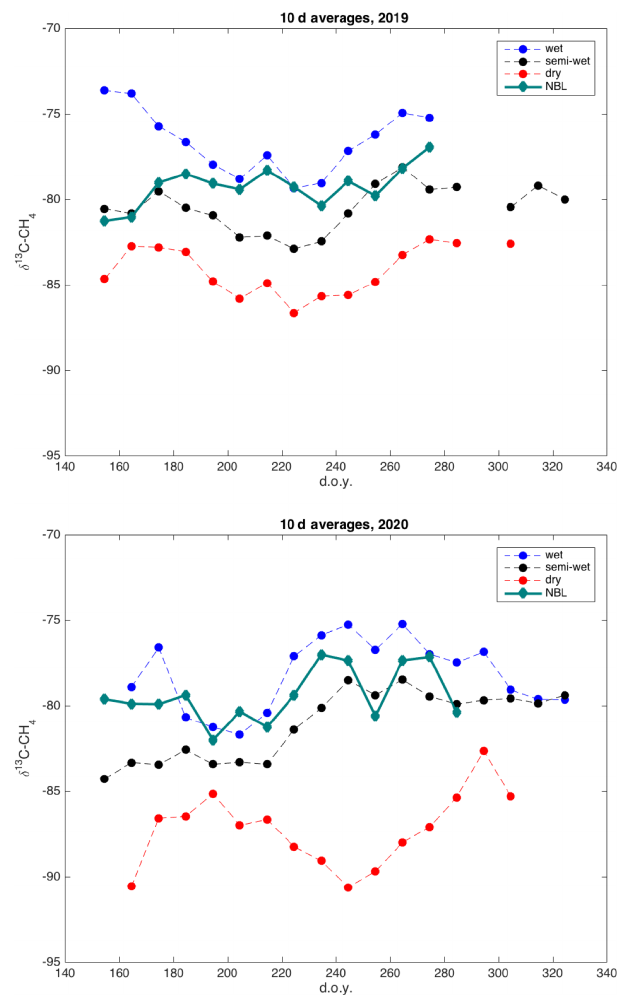
Figure 10. Time series of 10d average δ 13 C-CH 4 derived by noc- turnal boundary-layer Keeling plot approach (green) and averages of wet (blue), intermediate (black), and dry (red) locations, for 2019 and